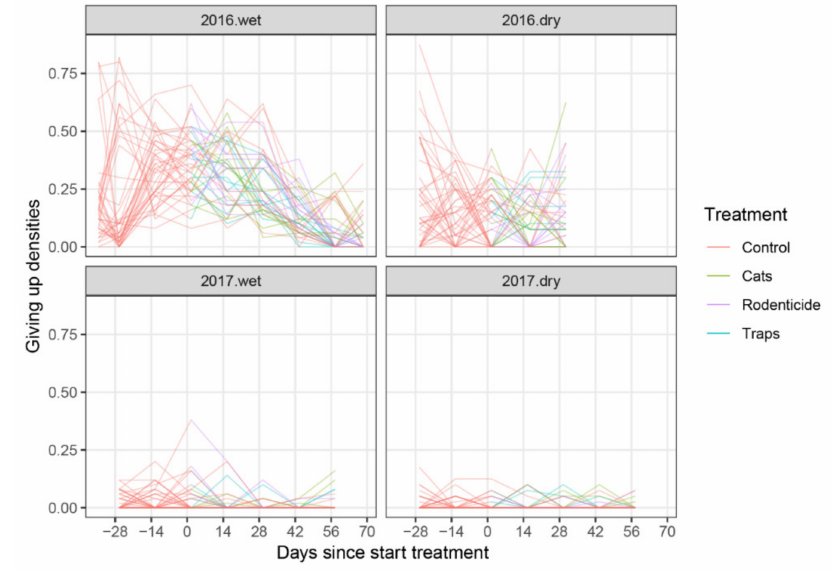
Figure 9. Percentage of peanuts eaten by rodents per day (averaged over two consecutive observation days) in a giving up density monitoring trial, split by year and season. Lines connect observations from the same household over time